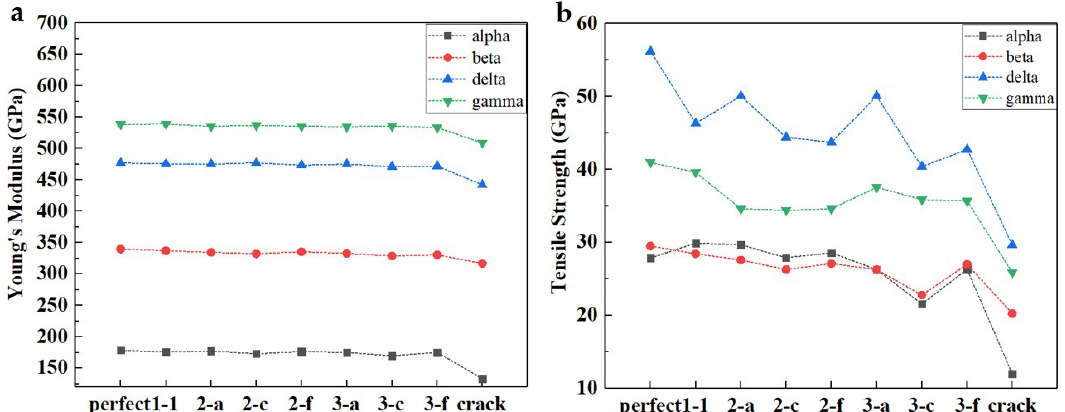
Figure 3. ( a ) The Young’s moduli of perfect graphyne and graphyne with vacancies or a crack, ( b ) The tensile strengths of perfect graphyne and graphyne with vacancies or a crack.